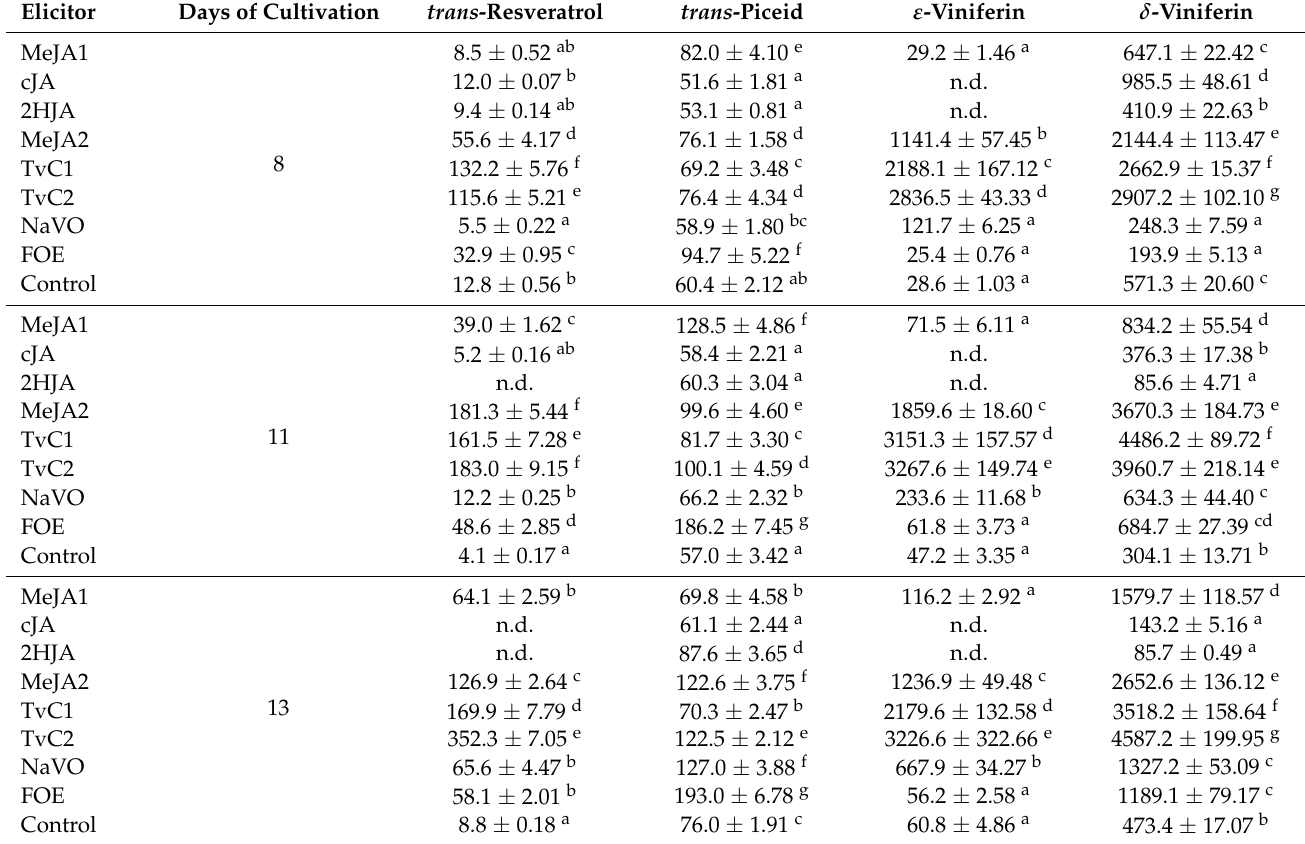
Table 1. The mean content of stilbenes in control and elicited (on the 6th day) grapevine cells cultured in vitro ( μ g/g, a–g statistically significant differences between values, n.d. not detected).